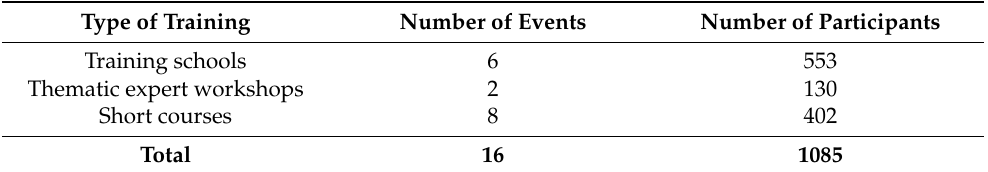
Table 2. Overview of training events, including numbers of training participants for each type of